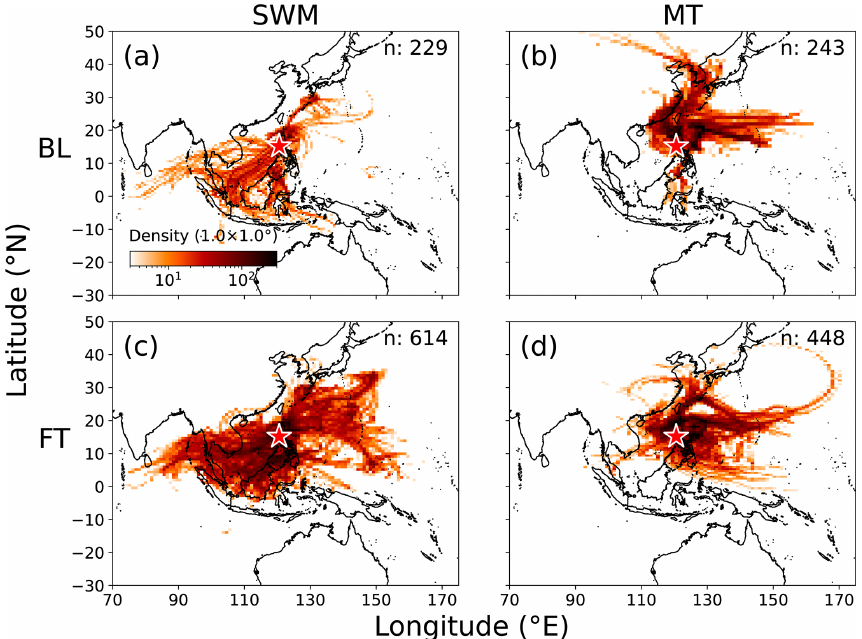
Figure 2. Trajectory densities resolved by monsoon phase and sampling vertical level. Monsoon phases are southwest monsoon (SWM; before 20 September 2019) and the monsoon transition (MT; after 20 September 2019). Vertical sampling levels are divided into boundary layer (BL; < 2km) and free troposphere (FT; > 2km). Red star denotes Clark International Airport, Philippines. Number of trajectories ( n ) is shown in the upper right of each